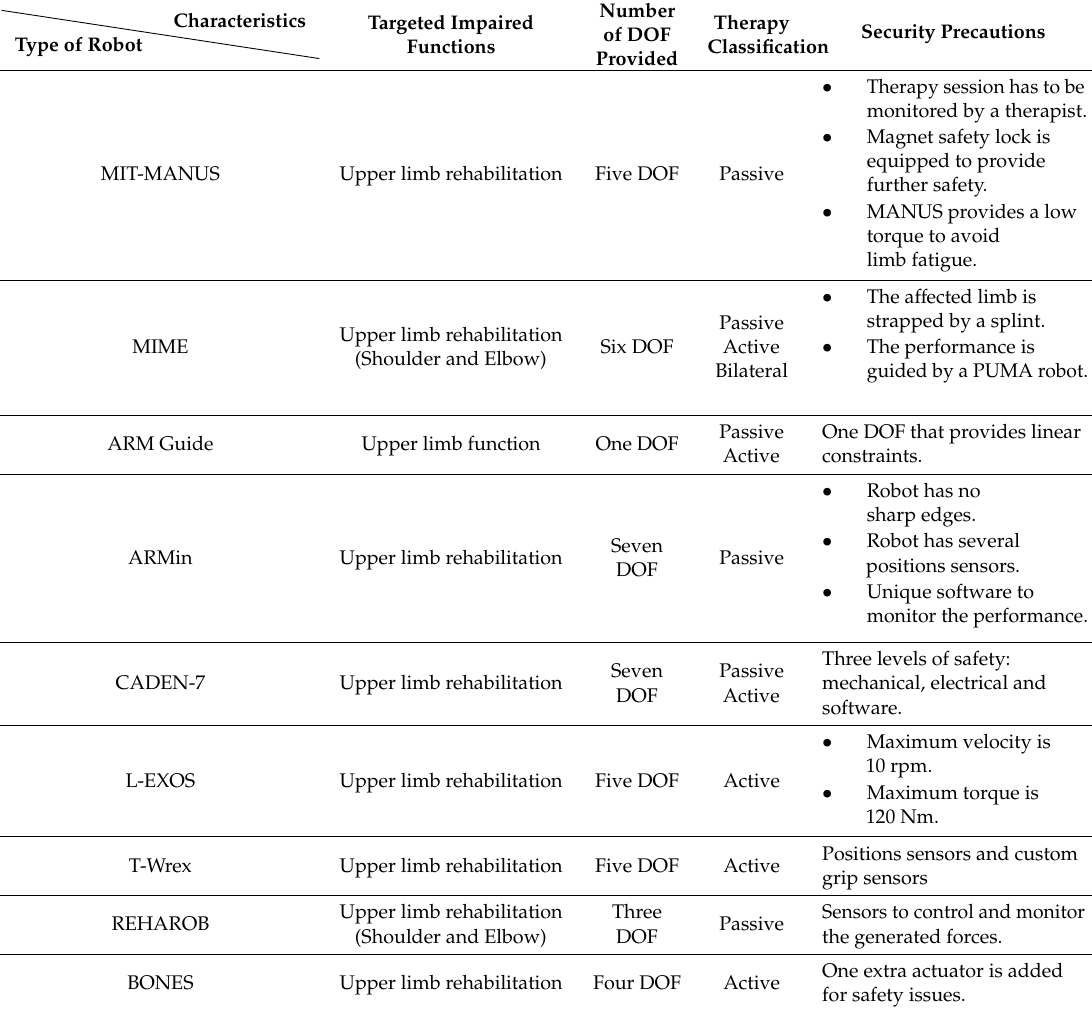
Table 3. Characteristics of the rehabilitation robots. DOF: degrees of freedom, MIME: mirror image movement enabler, ARM: Assisted Rehabilitation and Measurement, CADEN-7: cable actuated dexterous exoskeleton for neuro-rehabilitation with seven degrees of freedom, T-Wrex: therapy Wilmington exoskeleton and BONES: Biomimetic Orthosis for